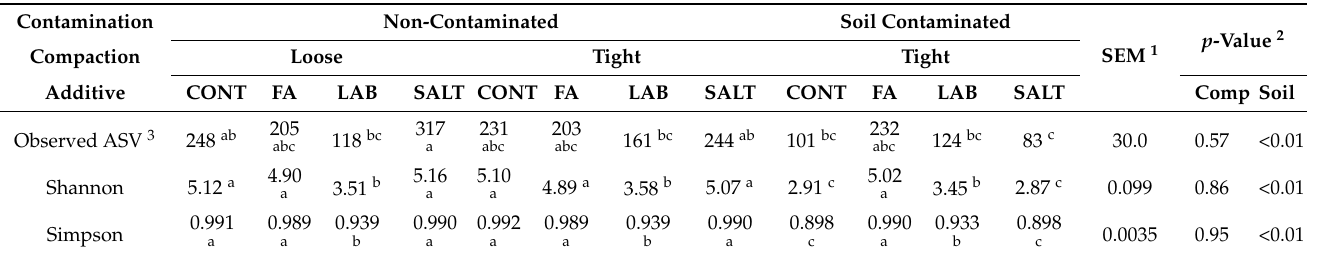
Table 3. Alpha diversity estimates of grass silage treated with different additives under two com- paction (Comp) and soil contamination (Soil) levels.